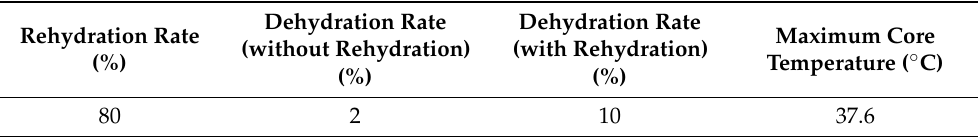
Table 6. Suggested thresholds of body dehydration and rehydration rates and maximum core temperature for